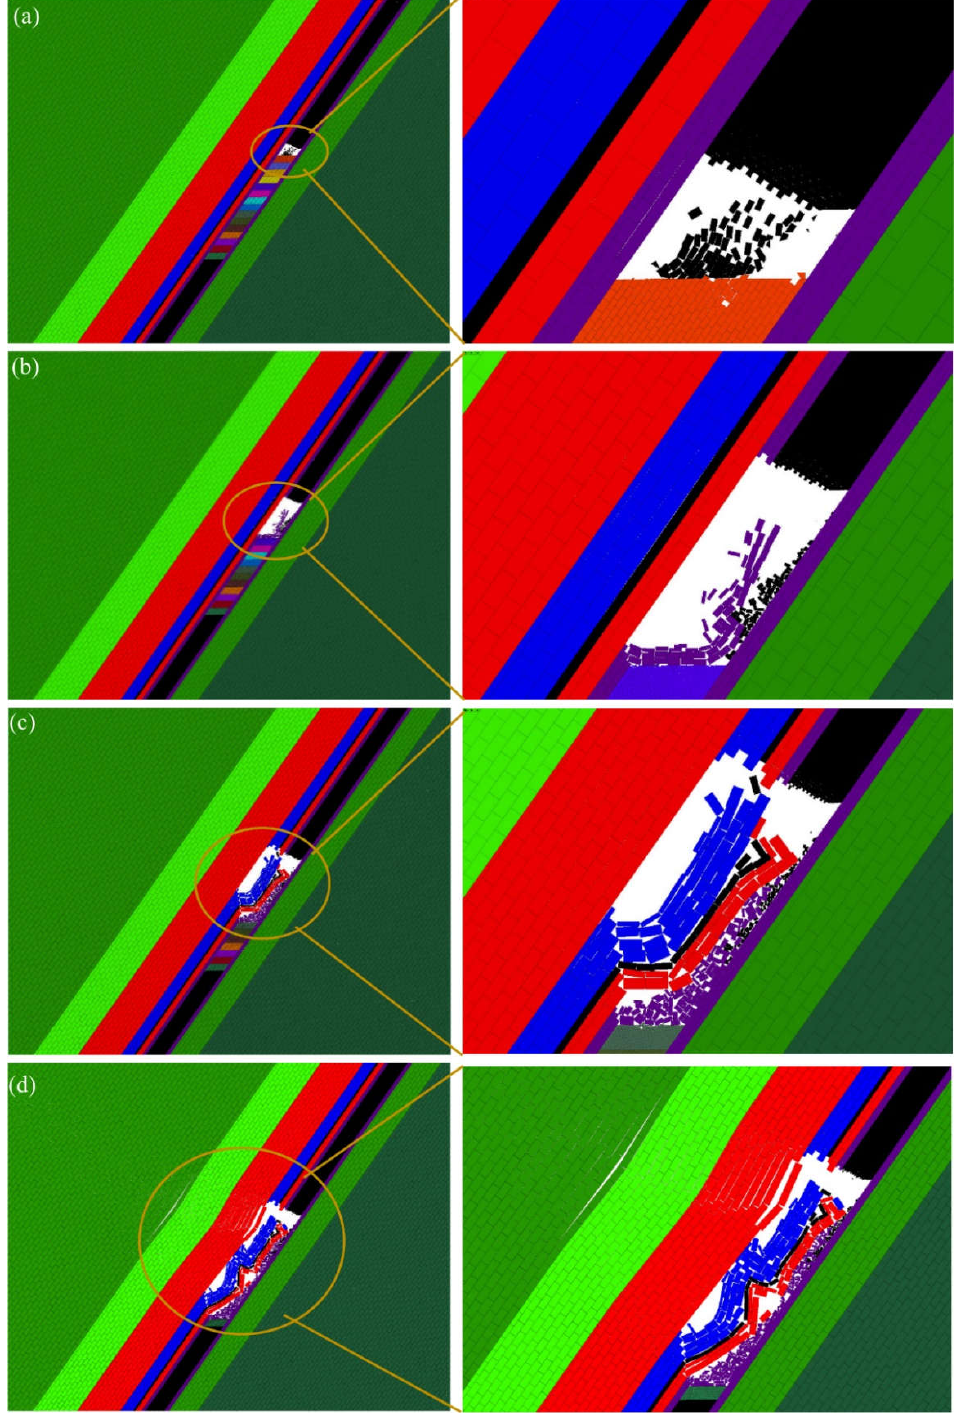
Figure 4. The motion states of the overburden rocks during the mining process: ( a ) the first slice; ( b ) the 5th slice; ( c ) the 8th slice and ( d ) the 15th slice.